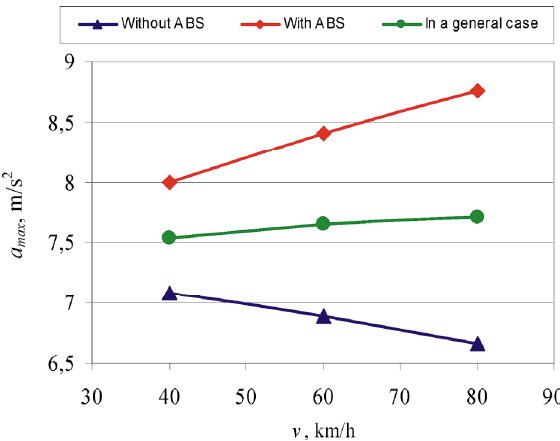
Fig 6. The dependence of the settled deceleration on the initial speed of movement of the vehicle